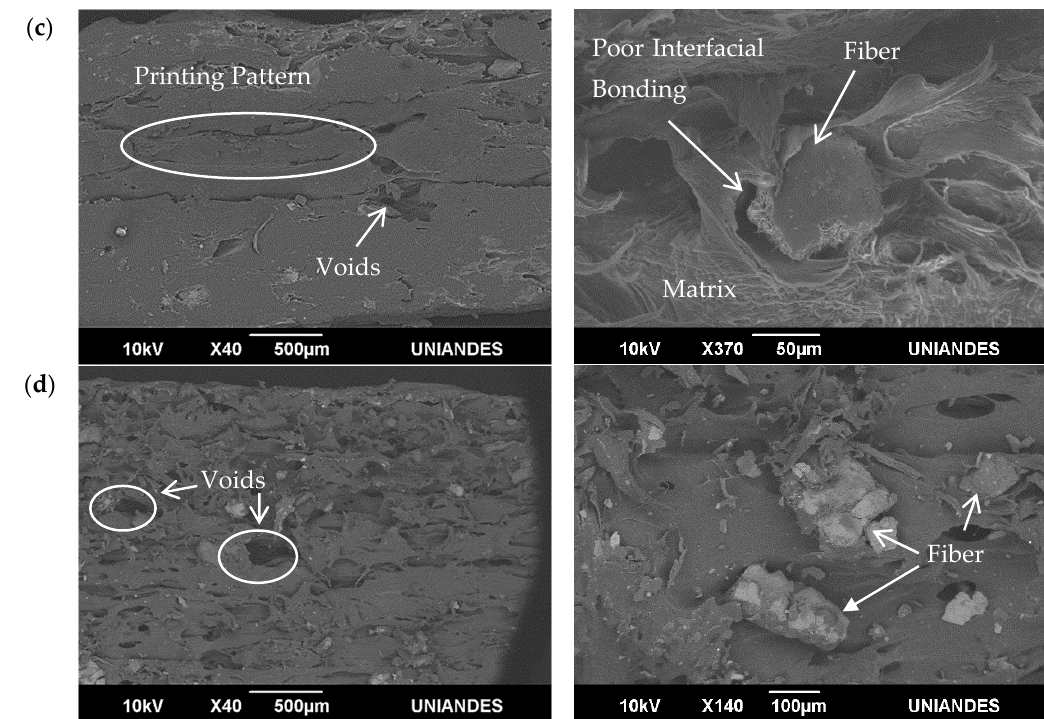
Figure 8. SEM images of tensile fractured specimens. ( a ) rPP/RH 5 wt.%. at 0 ◦ ; ( b ) rPP/RH 10 wt.%. at 0 ◦ ; ( c ) rPP/RH 5 wt.%. at 90 ◦ and ( d ) rPP/RH 10 wt.% at 90 ◦ . All the images were acquired at different magnifications in BEC